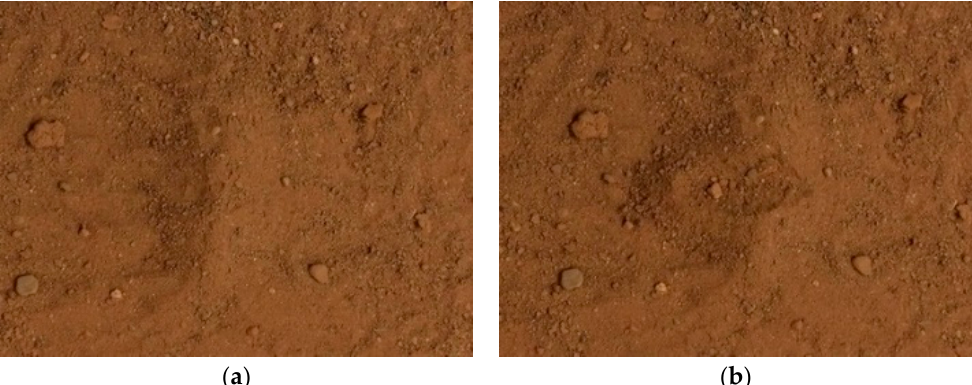
Figure 10. Simulation of lunar soil collection. ( a ) Before collection (vertical view); ( b ) After collection (vertical view).